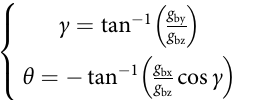
The discrete-time state equation model of Eq. (16) is established constant in the sampling period, where W k process noise and its covariance matrix Q k